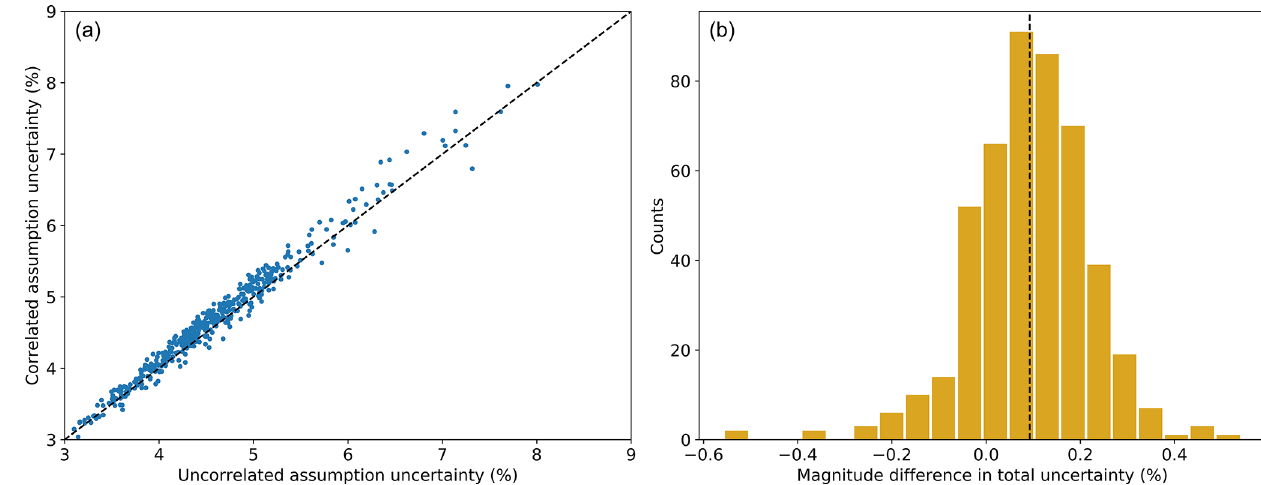
Figure 12. (a) Scatterplot of total operational AEP uncertainty values calculated with and without assuming uncorrelated uncertainty com- ponents for the 472 wind plants considered. Uncertainty is quantified as the percent coefficient of variation of the resulting long-term AEP distribution. (b) Histogram of difference, σ tot , corr − σ tot , uncorr , between the total operational AEP uncertainty calculated considering and ignoring the correlation between its uncertainty components.